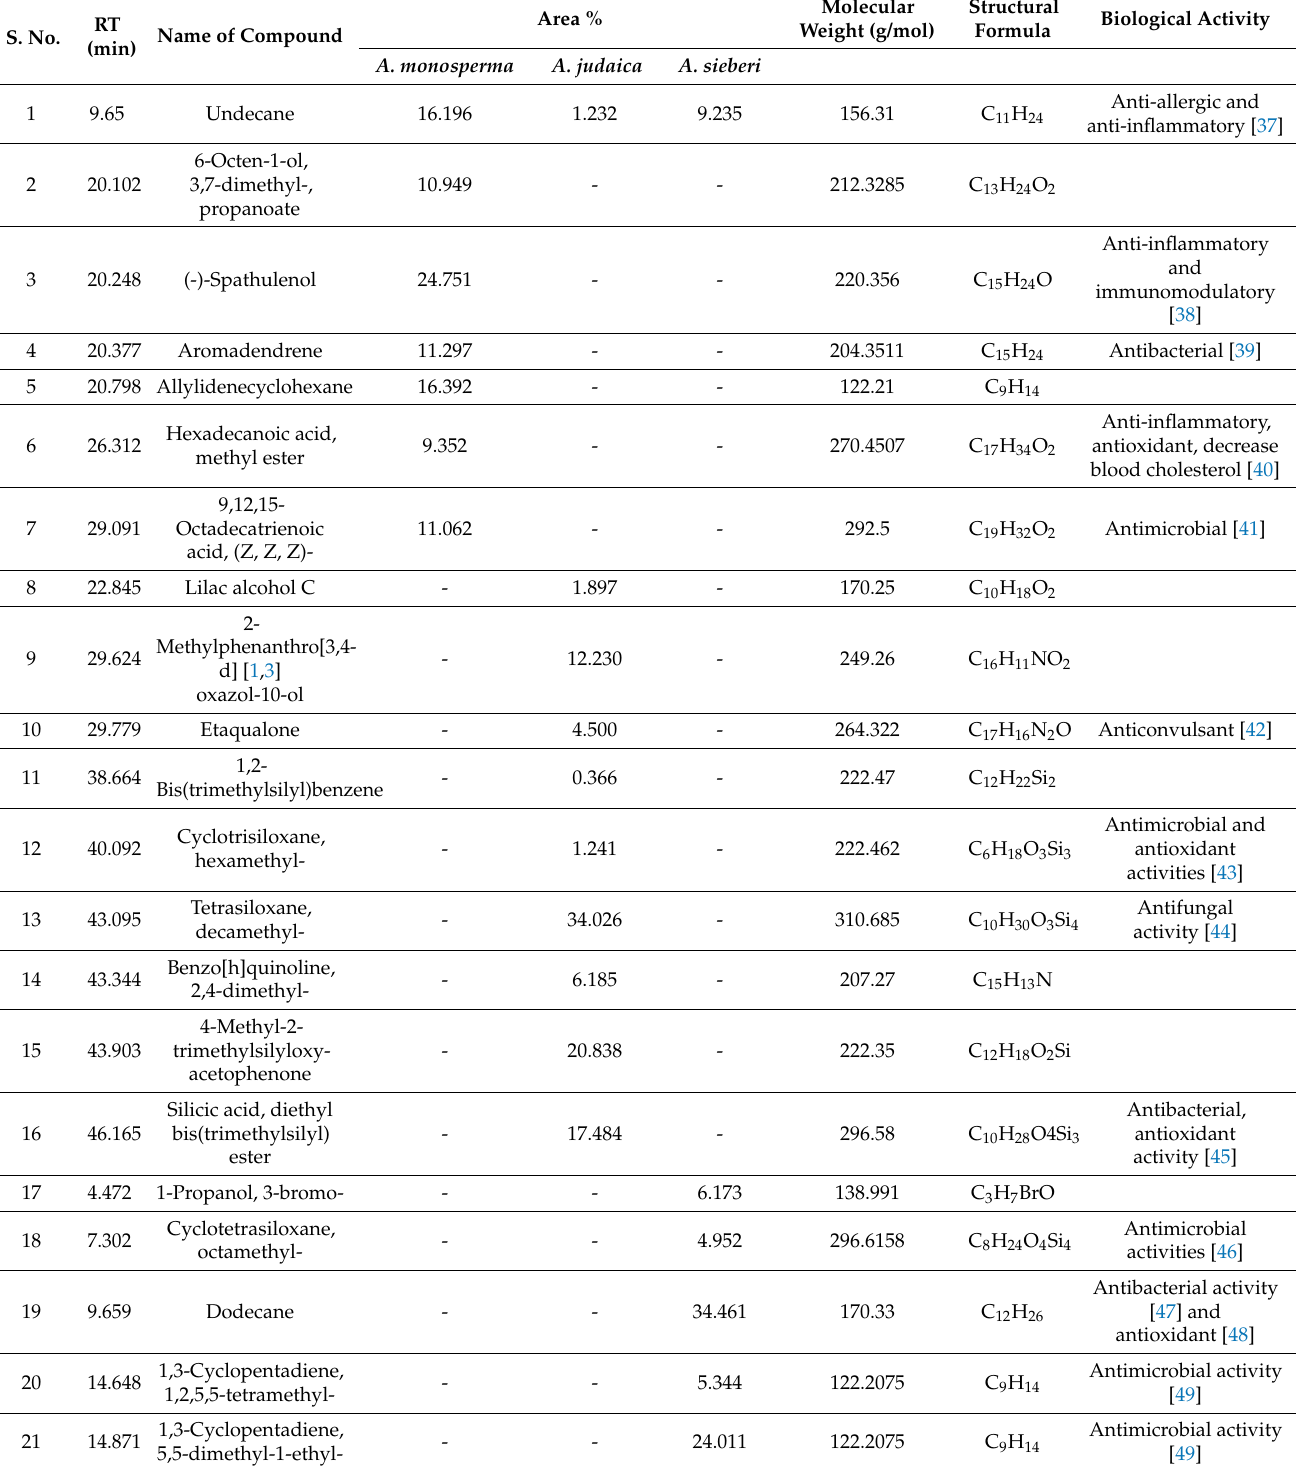
Table 1. Phytochemical compounds of Artemisia species ( A. monosperma , A. judaica , and A. sieberi ) detected using GC-MS analysis and their biological